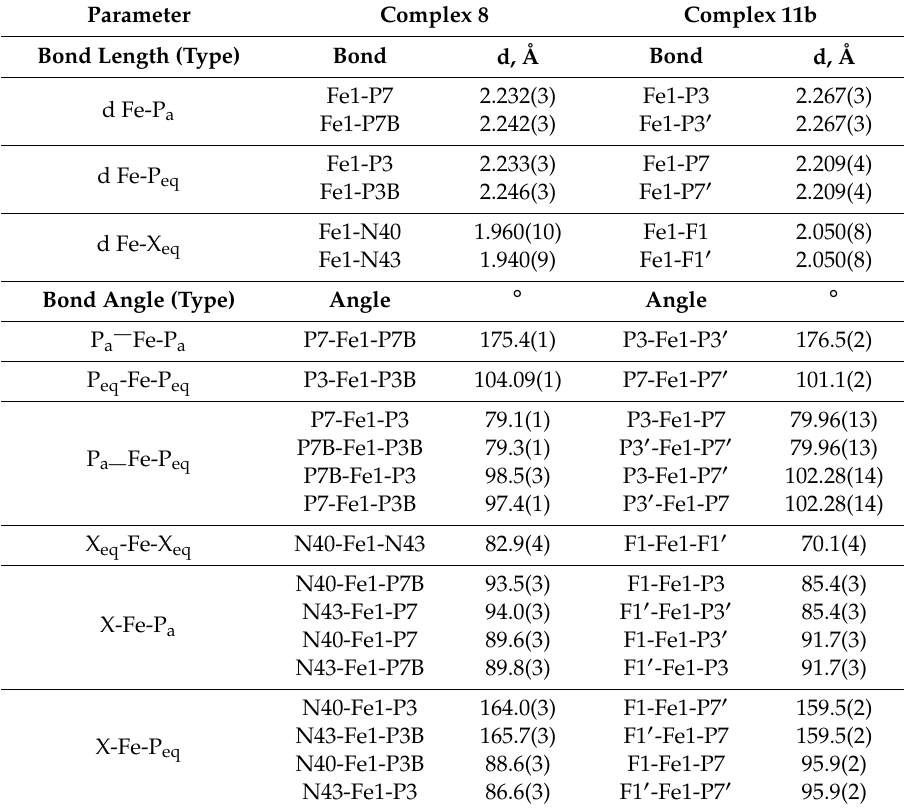
Table 1. Selected bond lengths and angles of complexes 8 and 11b